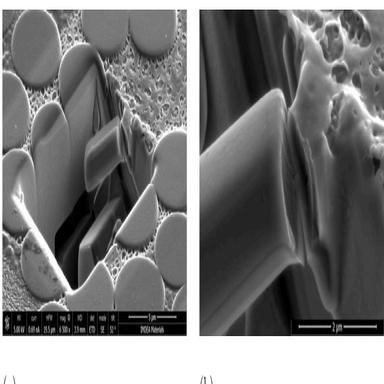
SEM image of mode II tested specimen, the complete detachment of the beam is visible in the image (b).